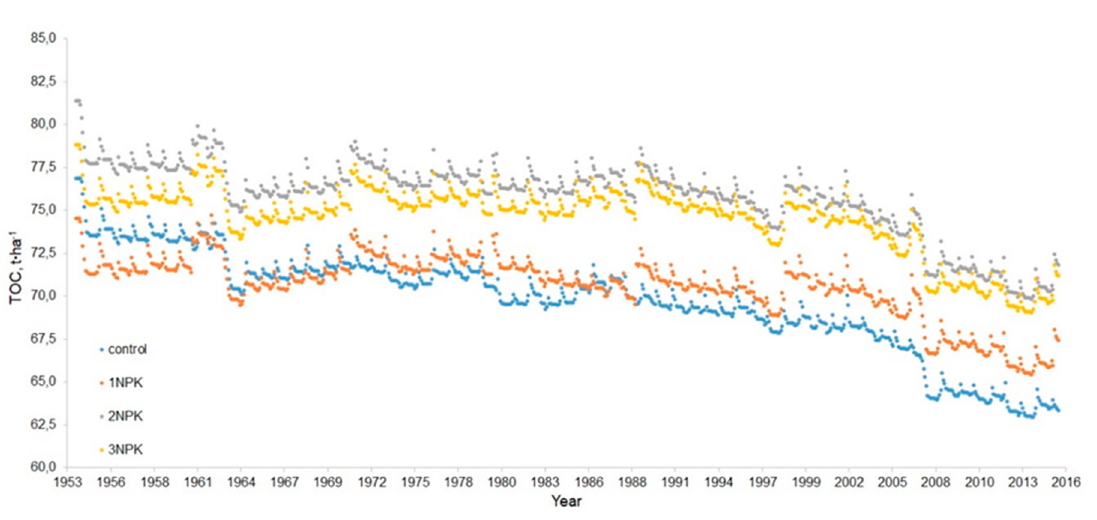
Table 3. Simulated changes in SOC stocks in the upper 20 cm of four treatments of the experiment for the period from 1954 to 2015 .